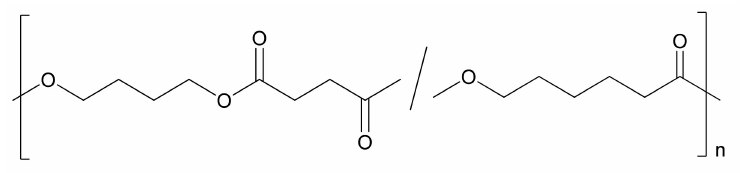
Figure 1. Chemical structure of PBS- ran -PCL